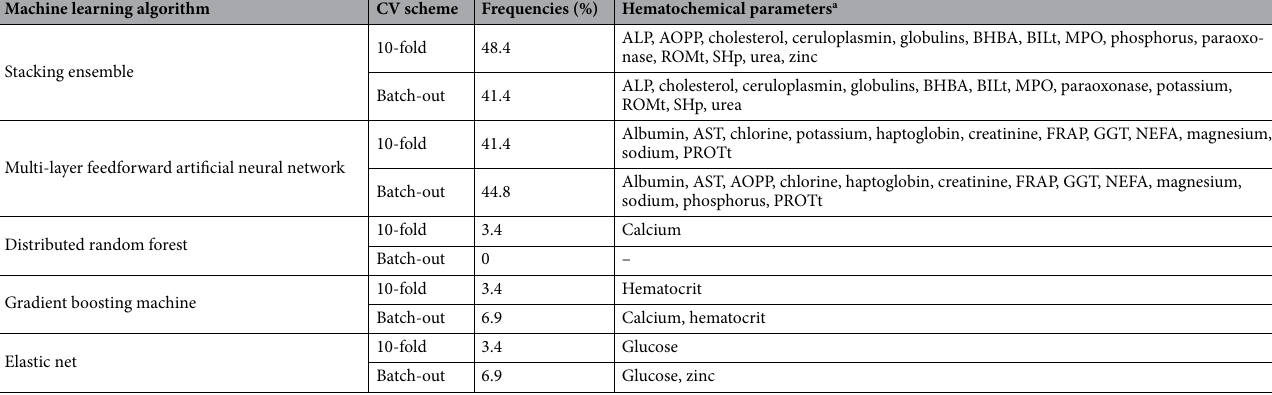
Table 3. Best machine learning approaches through different cross-validation (CV) scheme for hematochemical parameters expressed as frequencies (how many times each model is the best model for a given CV scheme for each hematochemical parameter prediction). a NEFA non-esterified fatty acids, BHBA β-hydroxybutyric acid, AST aspartate aminotransferase, GGT γ-glutamyl transferase, BILt total bilirubin, ALP alkaline phosphatase, PON paraoxonase, ROMt total reactive oxygen metabolites, AOPP advanced